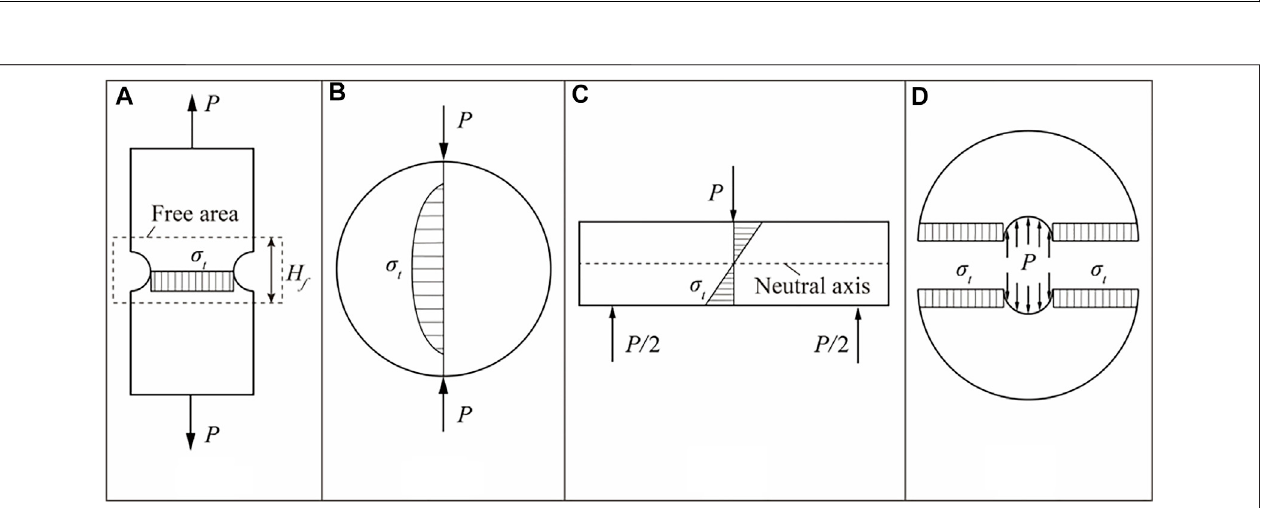
FIGURE 4 | Mechanical and kinematics models for (A) UDTT, (B) BT and HCT, (C) TPBT, and (D) IHFT.